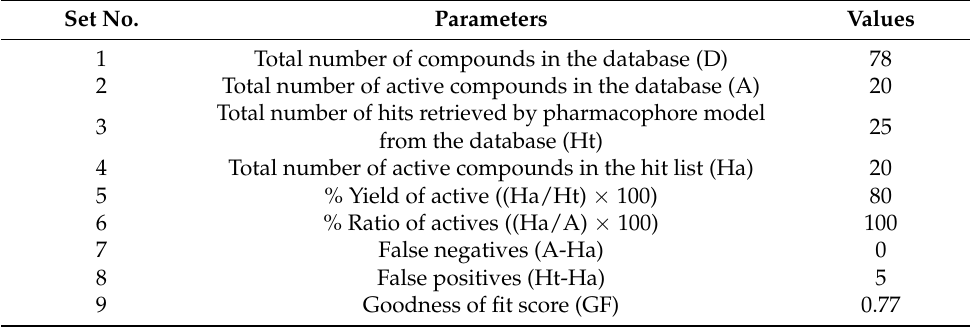
Table 2. Decoy set validation of Pharmacophore_01 from an external database composed of active ROS-1 inhibitors and decoy set